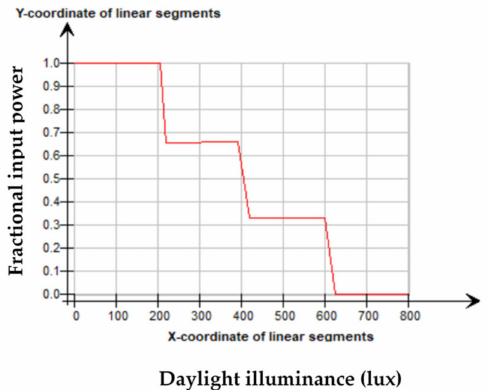
Figure 5. Control strategy of lighting defined in IDA-ICE 4.8, based on daylight